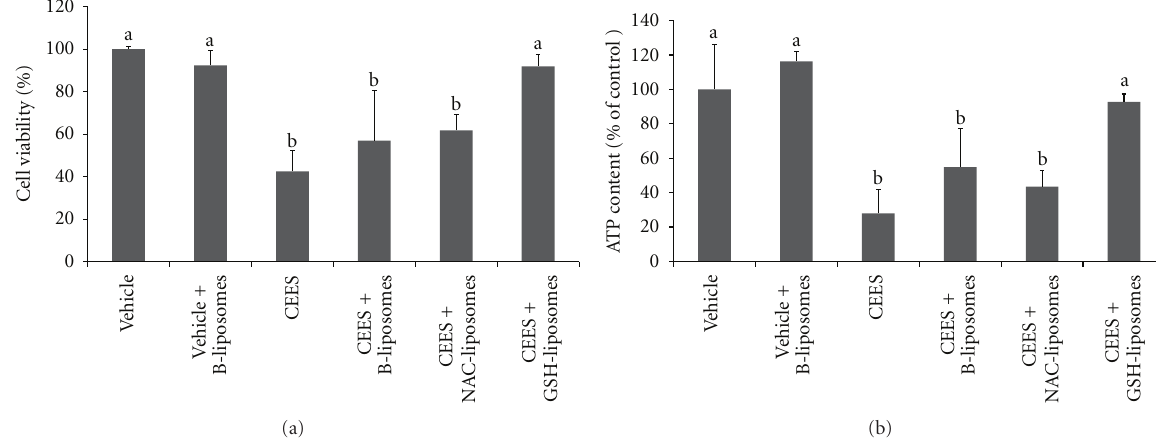
0510152025303540